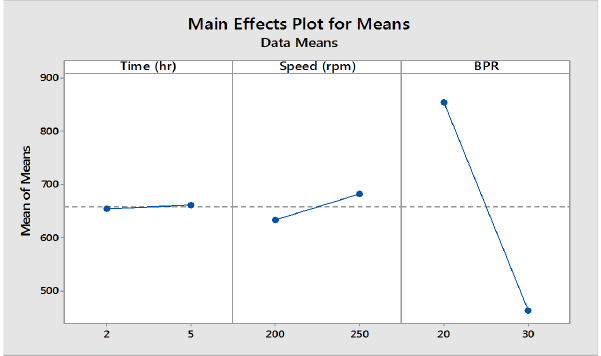
Fig. 4. The results of the average effect of the parameters under study on the average particle size.